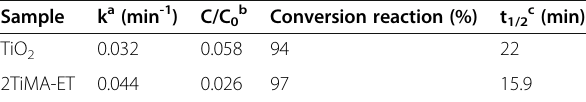
Table 2 Kinetic results of the photocatalytic degradation of MO (4 × 10 -5 M) under UV radiation Sample